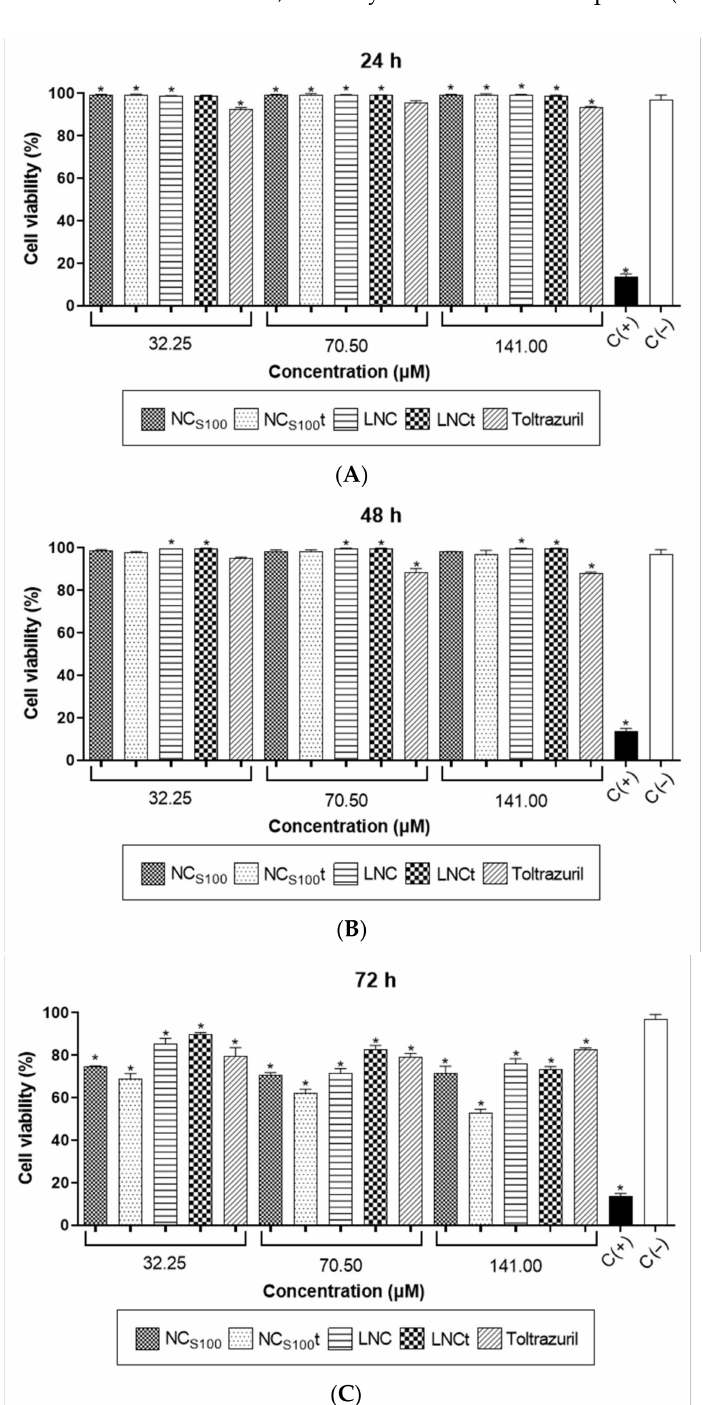
Figure 4. Cell viability of chicken fibroblasts (CEC-32 cell line) exposed to toltrazuril-loaded nanocap- sules based on membrane damage (LIVE/DEAD ® Viability/Cytotoxicity Kit) after ( A ) 24, ( B ) 48 and ( C ) 72 h. Data represent mean ± SD ( n = 3 − 4). * p < 0.05 vs. C( − ) (one-way ANOVA, post hoc Dunnett’s test). NC S100 = blank Eudragit ® S100 nanocapsules; NC S100 t = toltrazuril-loaded Eudragit ® S100 nanocapsules; LNC = blank lipid core nanocapsules; LNCt = toltrazuril-loaded lipid core nanocapsules; C(+) = positive control; C( − ) = negative control. Blank formulations (NC S100 and LNC) were added the same volume, respectively, to the drug-loaded